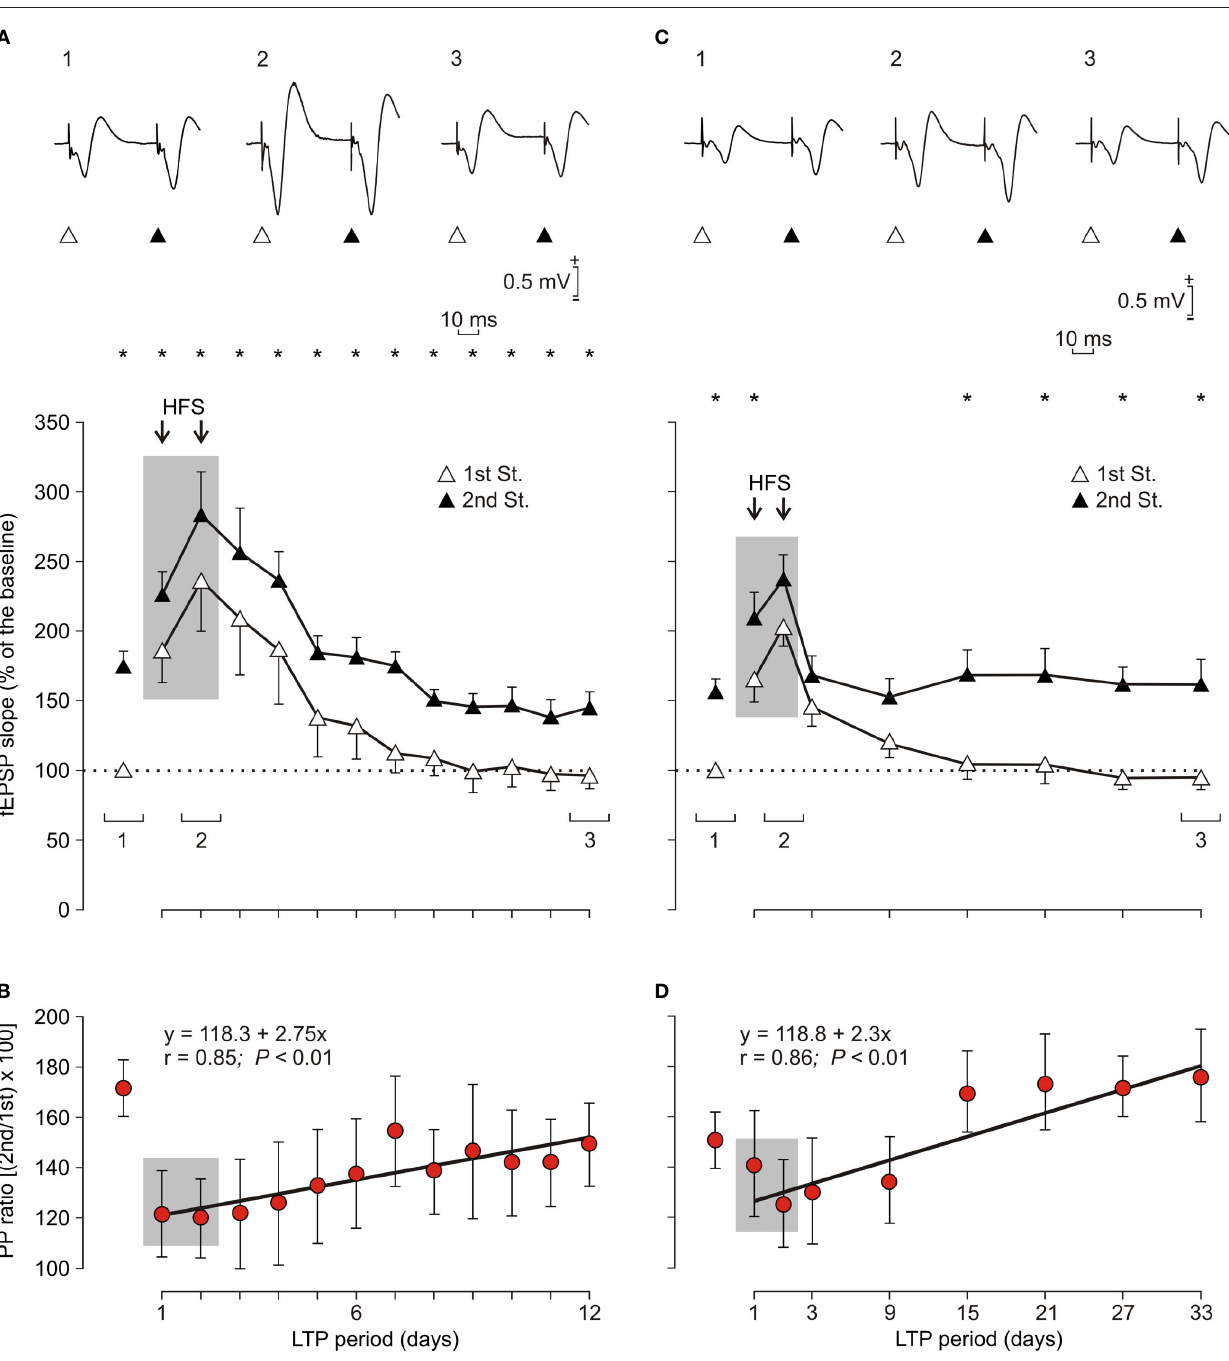
are illustrated some representative examples (averaged three times) of fEPSPs evoked at the CA3-CA1 synapse by paired-pulse stimulation (40 ms interval) collected prior to HFS (1), during the 2nd HFS session (2) and 10 (3, left) and 31 (3, right) days after it. Illustrated data correspond to mean ± SEM. * P < 0.001, for differences between the 1st and 2nd pulses, corresponding to data illustrated in (A) [F = 13.463] and (C) [F = 25.94]. (B, D) Note that fEPSP slopes (12,108) (8,72) decreased across recording days for both 1st and 2nd, but that their relationship, i.e., the paired pulse (PP) ratio [(2nd/1st) × 100; red circles and regression lines] increased steadily across time. Equations corresponding to the linear regression analyses of PP ratios are also indicated for the two sets of